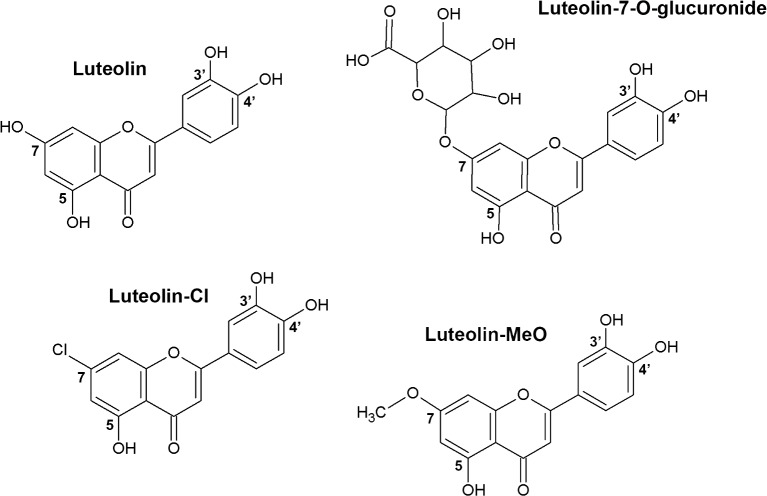
Chemical structures showing luteolin, luteolin-7-O-glucuronide, and the modified variants of luteolin where the 7-OH has been substituted with a chlorine (7-Cl-Lut) or a methoxy group (7-MeO-Lut).